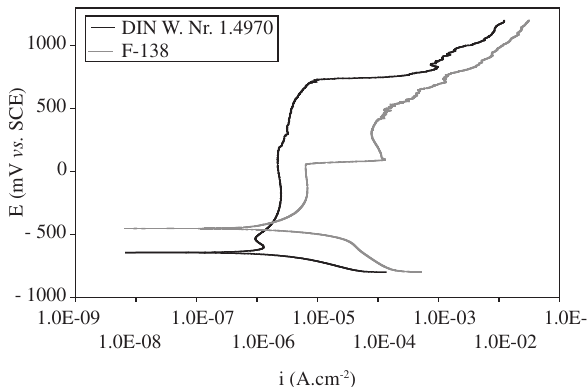
Figure 4. Potentiodynamic polarization curves for ASTM F-138 and DIN W. Nr. 1.4970 stainless steels in PBS solution at room temperature.